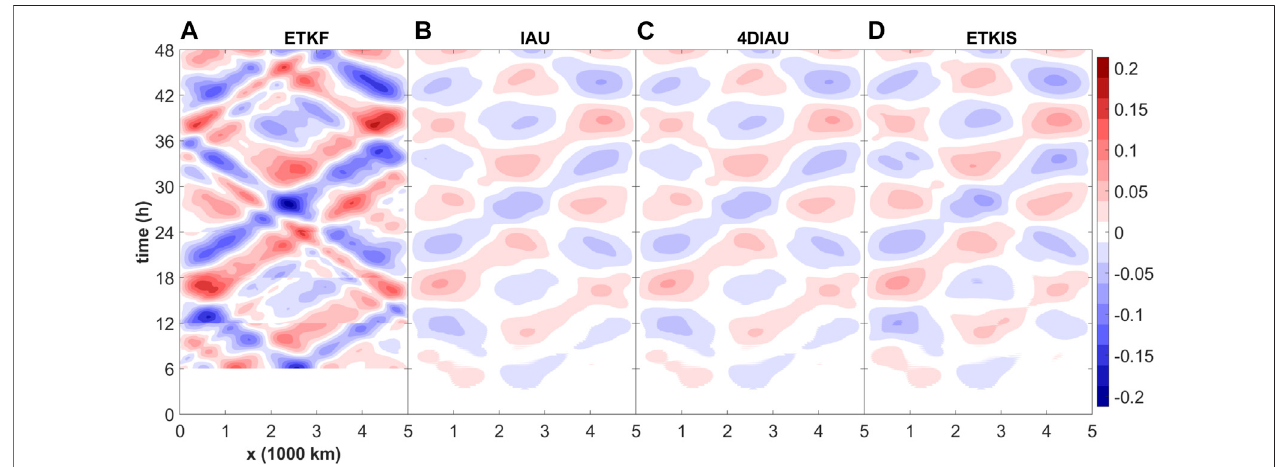
FIGURE 2 | Evolution of the ageostrophic v wind in the shallow water experiments using different DA schemes: (A) ETKF, (B) IAU (C) 4DIAU and (D) ETKIS. Experiments are initialized from a balanced condition.